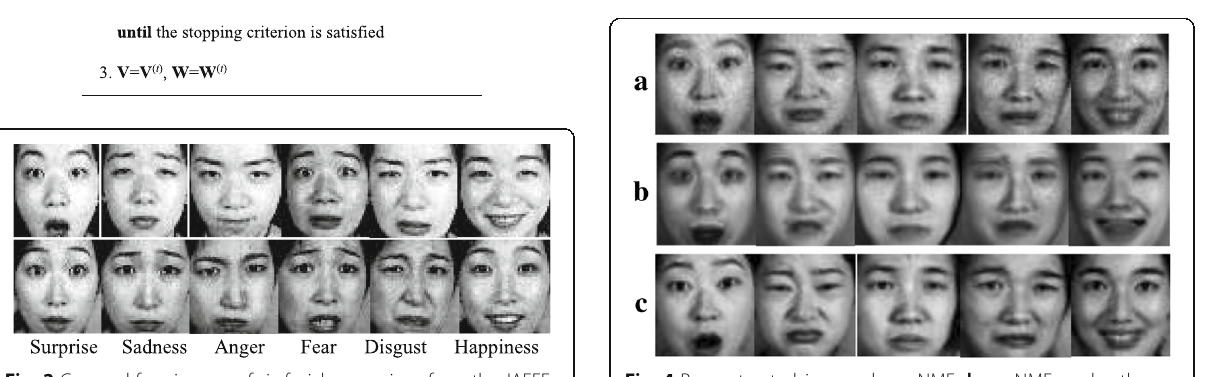
Fig. 2 Cropped face images of six facial expressions from the JAFFE